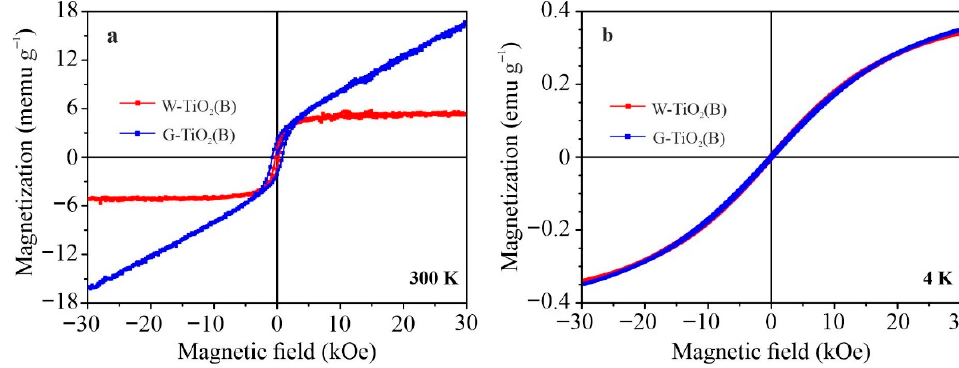
Figure 4. Magnetic hysteresis loops for W-TiO 2 (B) and G-TiO 2 (B) recorded at 300 K ( a ) and 4 K ( b ).